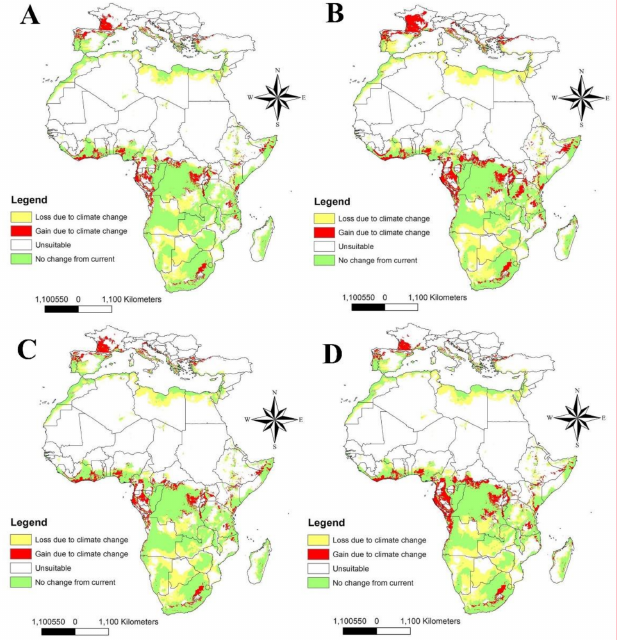
Figure 5. Calibration maps showing gain and loss in habitat suitability of LHB through the four future scenarios against current status: ( A ) 2050 for SSP 126; ( B ) 2050 for SSP 585; ( C ) 2070 for SSP 126, and ( D ) 2070 for SSP 585. LHB: Large Hive Beetle.